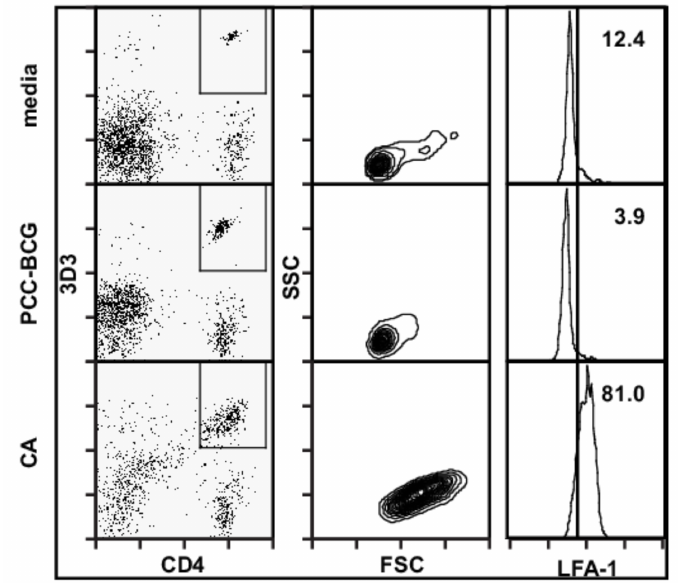
Figure 2. PCC-BCG does not activate D10 T cells in vitro. D10 spleen cells were cultured with PCC-BCG sonicates for 3 days in cRPMI10. D10 spleen cells were cultured with media alone ( top ) or with 100 µ g/mL CA ( bottom ) as negative and positive controls, respectively. Cells were harvested and stained with the D10 clonotypic antibody 3D3 and antibodies to CD4 and the activation marker LFA-1. Leftmost plots show CD4 and 3D3 expression on lymphocyte-gated cells. Middle plots show forward (FSC) and side scatter (SSC) on CD4 + 3D3 + T cells, and right plots show level of LFA-1 expression on CD4 + 3D3 + T cells. These data representative of three independent